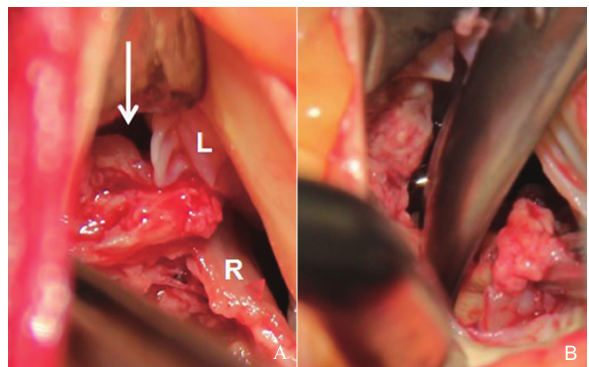
Figure 2 Intra-operative photos. (A) Perivalvular abscess was located below the attachment of the right and left coronary cusps, and the ruptured abscess was communicating with left ventricle (arrow); (B) Multiple vegetations were identified in the abscess cavity and right coronary cusp. R, right coronary cusp; L, left coronary